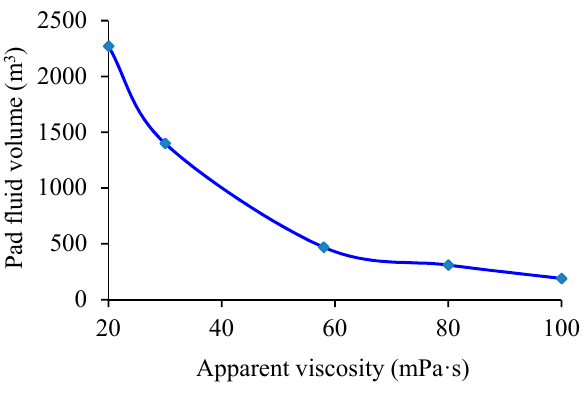
Figure 11. Curve of the relationship between pad fluid volume and its apparent viscosity.